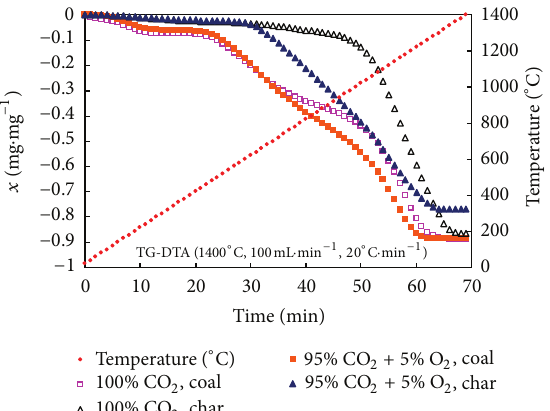
Figure 19: TG comparisons of coal and char in the CO 2 -rich atmosphere.